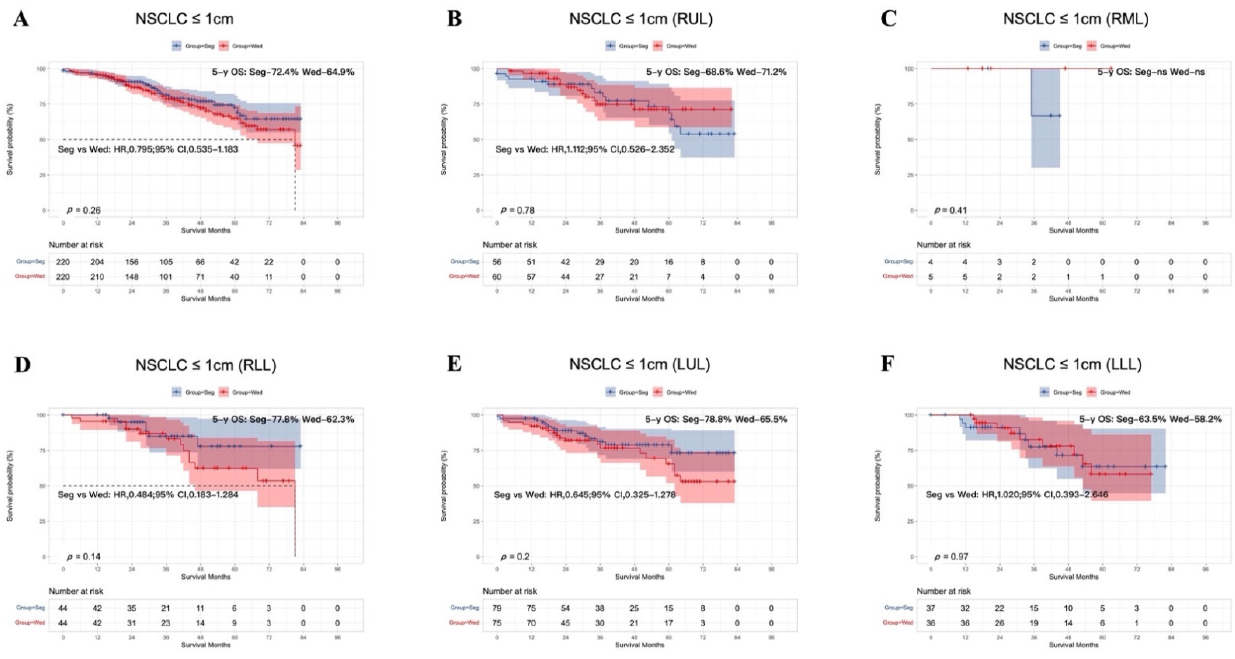
Figure 3. Kaplan–Meier survival curves after segmentectomy or wedge resection in NSCLC patients with tumors ≤ 1 cm after PSM ( A ). Survival curves for the RUL ( B ), RML ( C ), RLL ( D ), LUL ( E ), and LLL ( F ) after PSM.